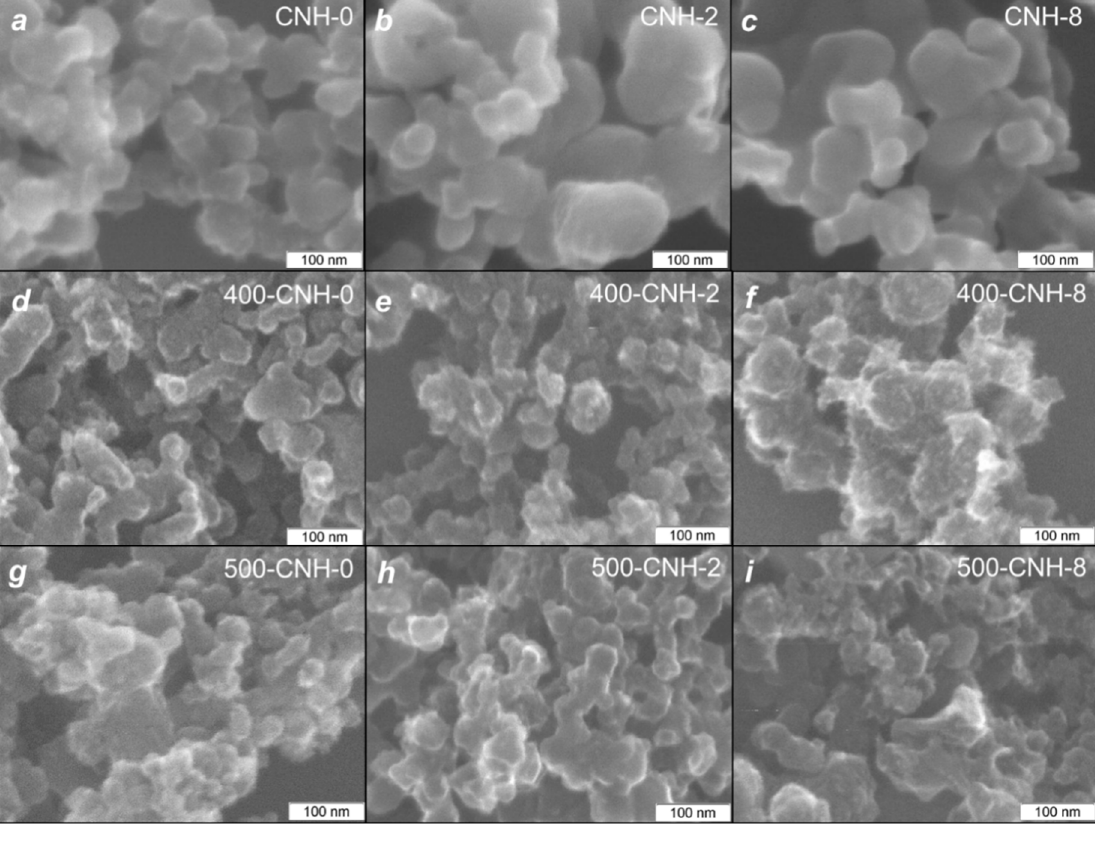
Figure 2. SEM images of initial CNH samples ( a – c ) and those oxidized at 400 ° С ( d – f ) and 500 ° С ( g – i ).